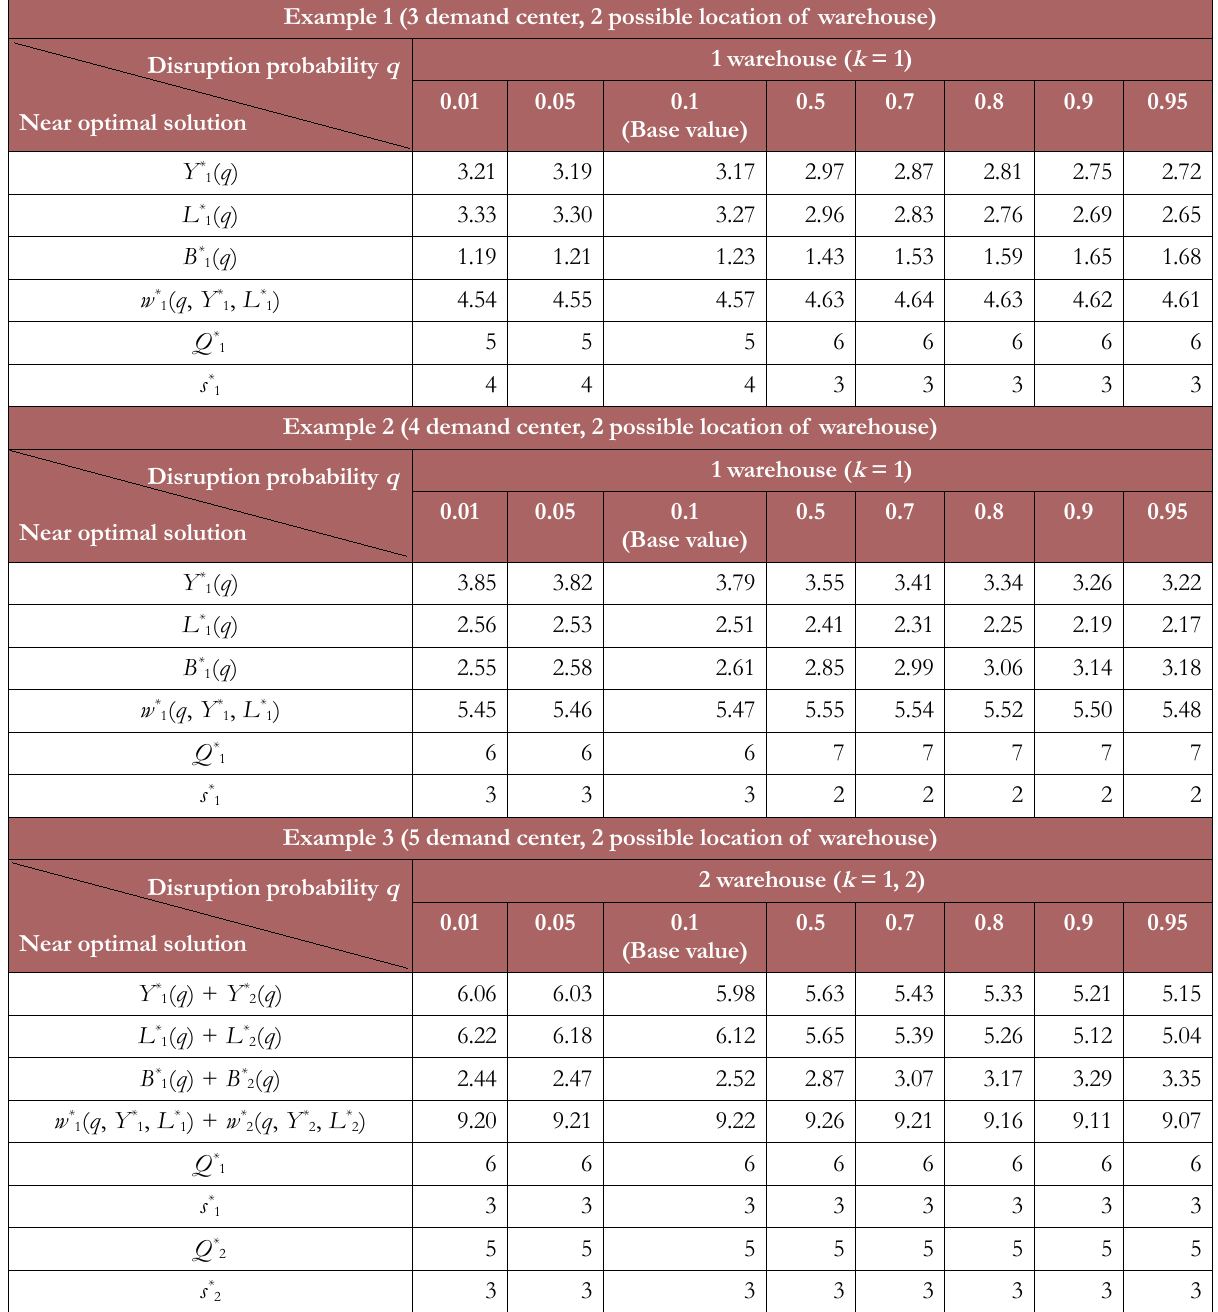
Table 6. Impact of the facility disruption